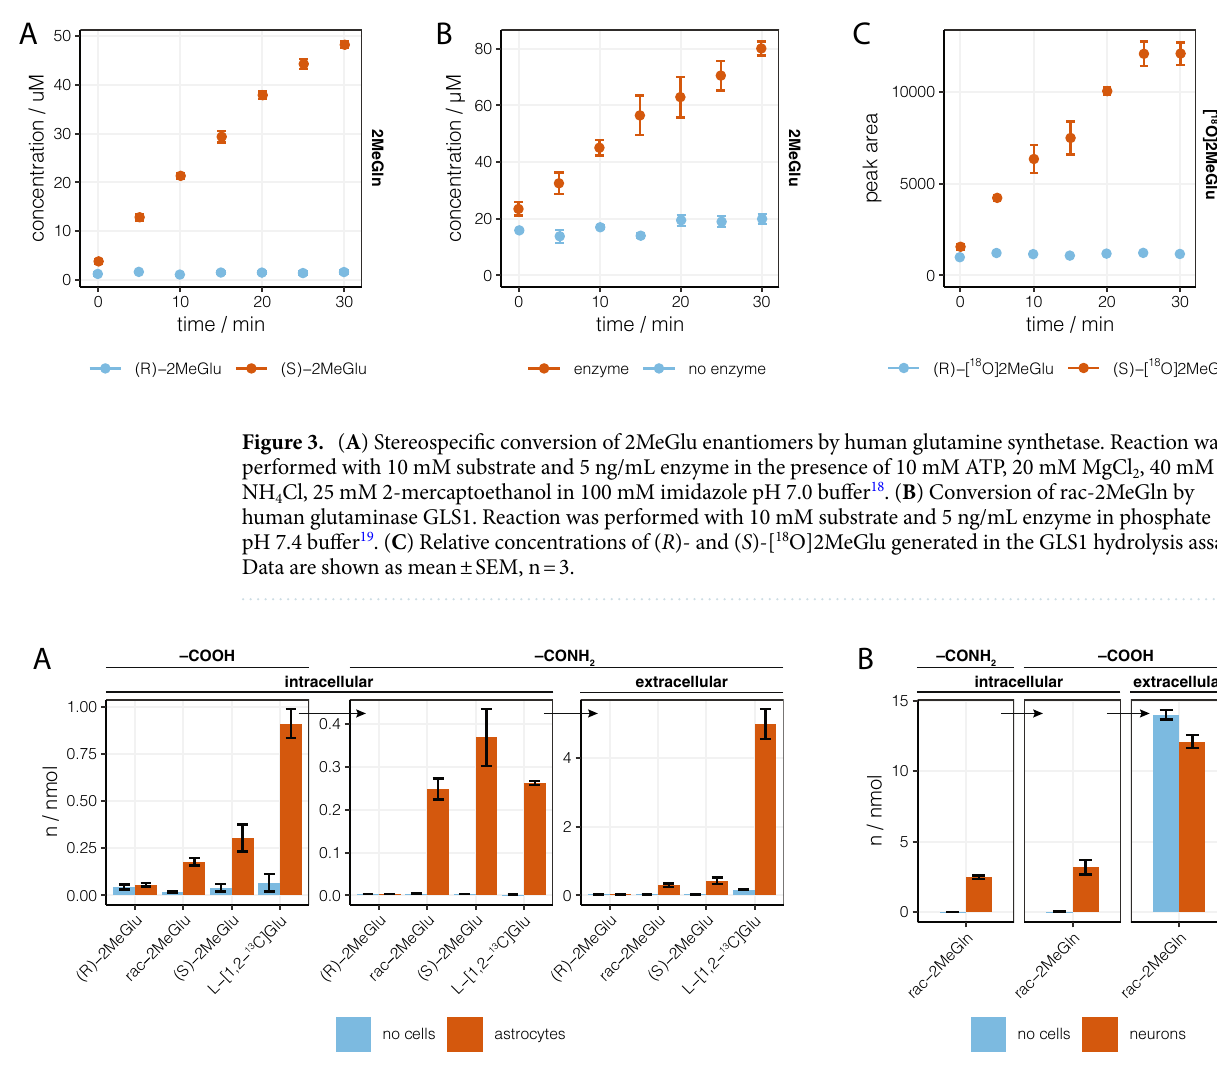
Figure 4. Cell metabolism of 2MeGlu and 2MeGln. Data are shown as mean ± SEM, n = 3. Horizontal arrows represent an uptake–conversion–release cycle. ( A ) Astrocyte uptake, amidation, and release of 2MeGlu and its amide derivative, 2MeGln. Total intra- and extracellular amounts of 2MeGlu or [1,2- 13 C]Glu (–COOH) and 2MeGln or [1,2- 13 C]Gln (–CONH 2 ) were determined in cells and media. Primary astrocyte cultures were incubated in the presence of 1 mM of racemic or enantiopure 2MeGlu or l-Glu for 2 h at 37 °C along with cell- free controls. ( B ) Neuronal uptake, hydrolysis, and release of 2MeGln and its hydrolyzed counterpart 2MeGlu. Total intra- and extracellular amounts of 2MeGln (–CONH 2 ) and 2MeGlu (–COOH) were determined in cells and media. Primary neuron cell cultures were incubated in the presence of 1 mM 2MeGln for 2 h at 37 °C along with cell-free